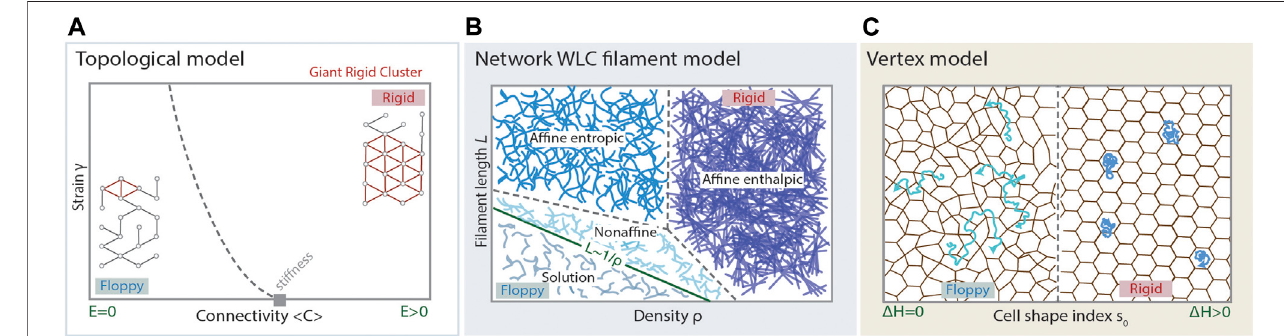
FIGURE 2 | Modelling cell and tissue viscoelasticity. (A) Phase diagram of the regimes arising in a topological model for rigidity, such as stiffness percolation, predicting a fl oppy to rigid transition at a critical point of average connectivity of the underlying network (grey rectangle). A random network displaying average connectivity below the isostatic point (critical point), has a small Giant Rigid Cluster (red) and the whole network is fl oppy, displaying Young ’ s modulus E (cid:1) 0. The same network,exhibitingconnectivityabovethecriticalpointformsabigGiantRigidClustermakingthewholenetworkrigid,hencedisplaying E > 0.Figureadaptedfrom [31, 138]. (B) Phase diagram of the network of WLC fi laments ’ model showing strain-stiffening response of semi fl exible biopolymer networks. At low density and low fi lamentlength,thenetworkisin solutionand ina fl oppyregime. Thesolidlineindicates therigidity percolation transitionwhere thenetworkgainsstability above acritical densityandlength,andcanbeapproximatedby L ∼ 1 / 9 .Atintermediatedensitybutlongerlengths,thenetworkdisplaysanaf fi neelasticdeformationduetotheentropic stretchingofthe fi laments.Athigherdensitythenetworkdisplaysanaf fi neelasticdeformationdominatedbytheenthalpicstretchingandbendingofthenetworkandisin a rigid regime. Figure adapted from [26]. (C) Phase diagram of a vertex model predicting a fl oppy to rigid phase transition in simulated con fl uent tissues. Below a critical pointofacellshapeindex s 0 (de fi nedbycell-celladhesionandcellcontractility)cellsarefreetomoveanddisplay highmeansquareddisplacement(longcelltrajectories) and thetissue is fl uid-like, thanksthattheincrease ofenergy duetocell-cellrearrangements Δ H (cid:1) 0.Above thecriticalpoint cellsacquire ahexagonalshapeand display caged limited motion (short cell trajectories), and cell-cell rearrangements have a positive energy penalty Δ H > 0. Figure adapted from [27,